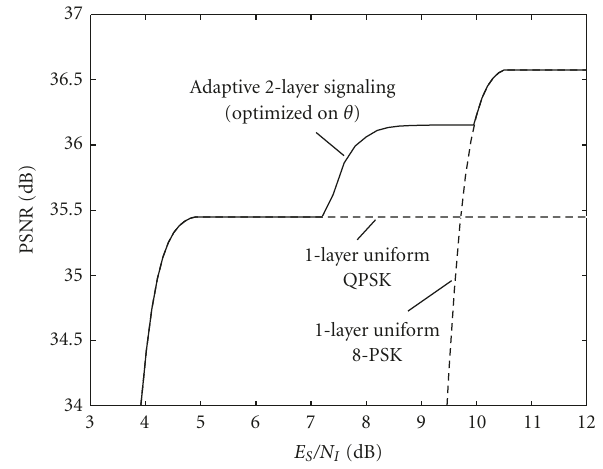
Figure 10: PSNR as a function of E S /N I in dB for AWGN channel: (1) 1-layer schemes with fixed channel code using uniform QPSK or 8-PSK, and (2) a 2-layer adaptive modulation scheme with fixed channel codes, optimized on θ . Fixed symbol transmission rate r S = 128